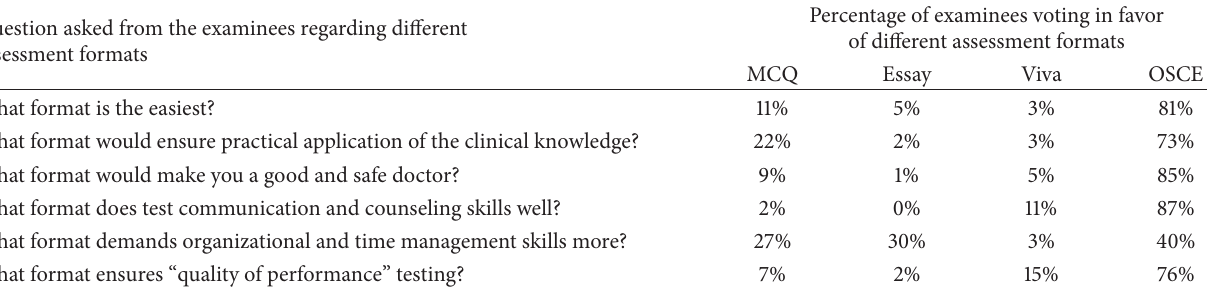
Table 1: Students rating of different assessment formats.